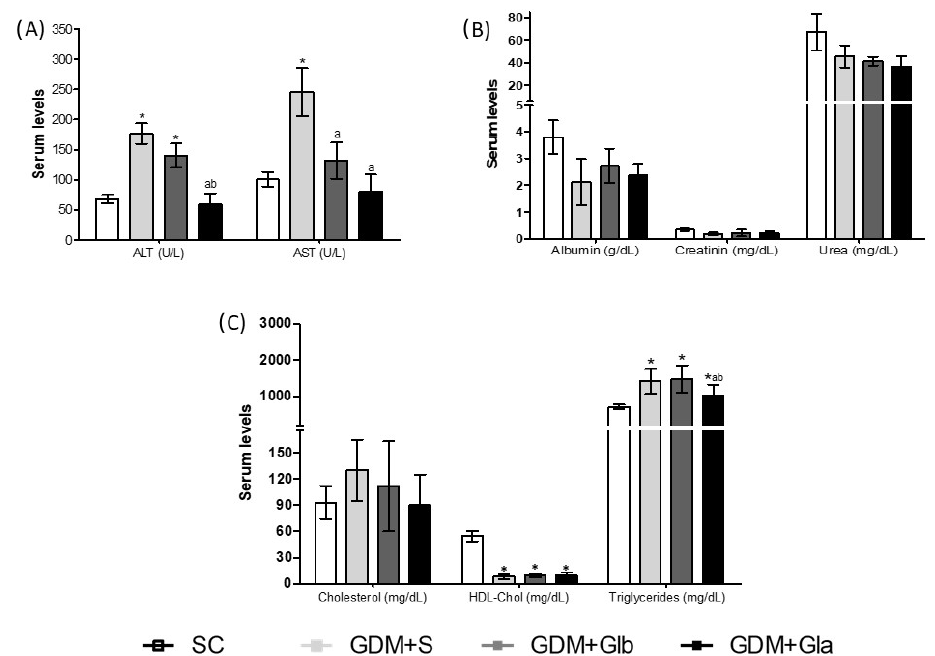
Figure 2. Biochemical parameters in GDM-STZ of maternal serum. SC (0.9% saline solution), GDM+S (Diabetic + saline solution 0.9%), GDM+Glb (Diabetic + 100 mg/kg/day of Ganoderma lucidum from gestation day 1 to 19), GDM+Gla (Diabetic + 100 mg/kg/day of Ganoderma lucidum from gesta- tion day 9 to 19). ( A ) represent hepatic profile AST (aminotransferase de aspartate), ALT (ami- notransferase de alanine). ( B ) shows renal function Albumin, Creatinin and Urea. ( C ) is lipid profile Cholesterol, HDL-Chol (high-density lipoproteins) and Triglycerides. Data are presented as mean ± SD ( n = 6). (*) p < 0.05 in comparison to the SC group, (a) in comparison to the GDM+S group, (b) in comparison to the GDM+Glb group, One-way ANOVA, followed by Tukey–Kramer’s test. Figure 3 shows the biomarkers of the redox state in maternal blood. CAT activity in GDM+S and GDM+Glb in relation to SC and GDM+Gla tended to decrease (F = 2.733; p = 0.0901). In relation to GPx, the GDM groups showed a decrease in enzyme activity. The GDM+S group showed an increased concentration of TBARS when compared to the SC group and to the groups exposed to Gl (F = 16.54, p = < 0.0001).